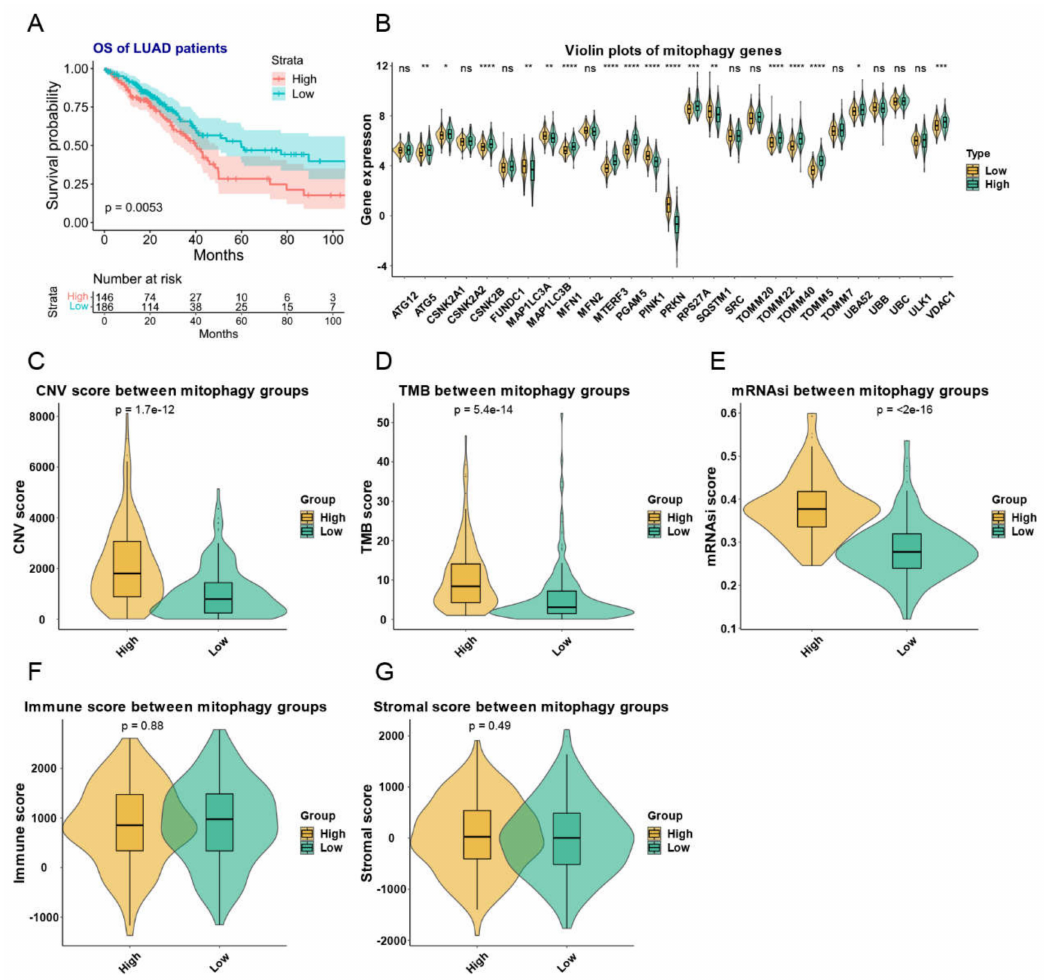
Figure 5. The mitophagy clusters and their relationship with TMB, total CNVs, stem cell phenotype and immune and stromal scores in LUAD. ( A ) the KM plot of the different mitophagy clusters. ( B ) The expression pattern of mitophagy genes between the two mitophagy groups. The asterisks represented the statistical p value ( ns p > 0.05; * p < 0.05; ** p < 0.01; *** p < 0.001; **** p < 0.0001). ( C – G ) the violin plots presented the association between mitophagy groups and TMB ( C ), total CNVs ( D ), stem cell phenotype ( E ) and immune ( F ) and stromal scores ( G ) in TCGA-LUAD cohort. The